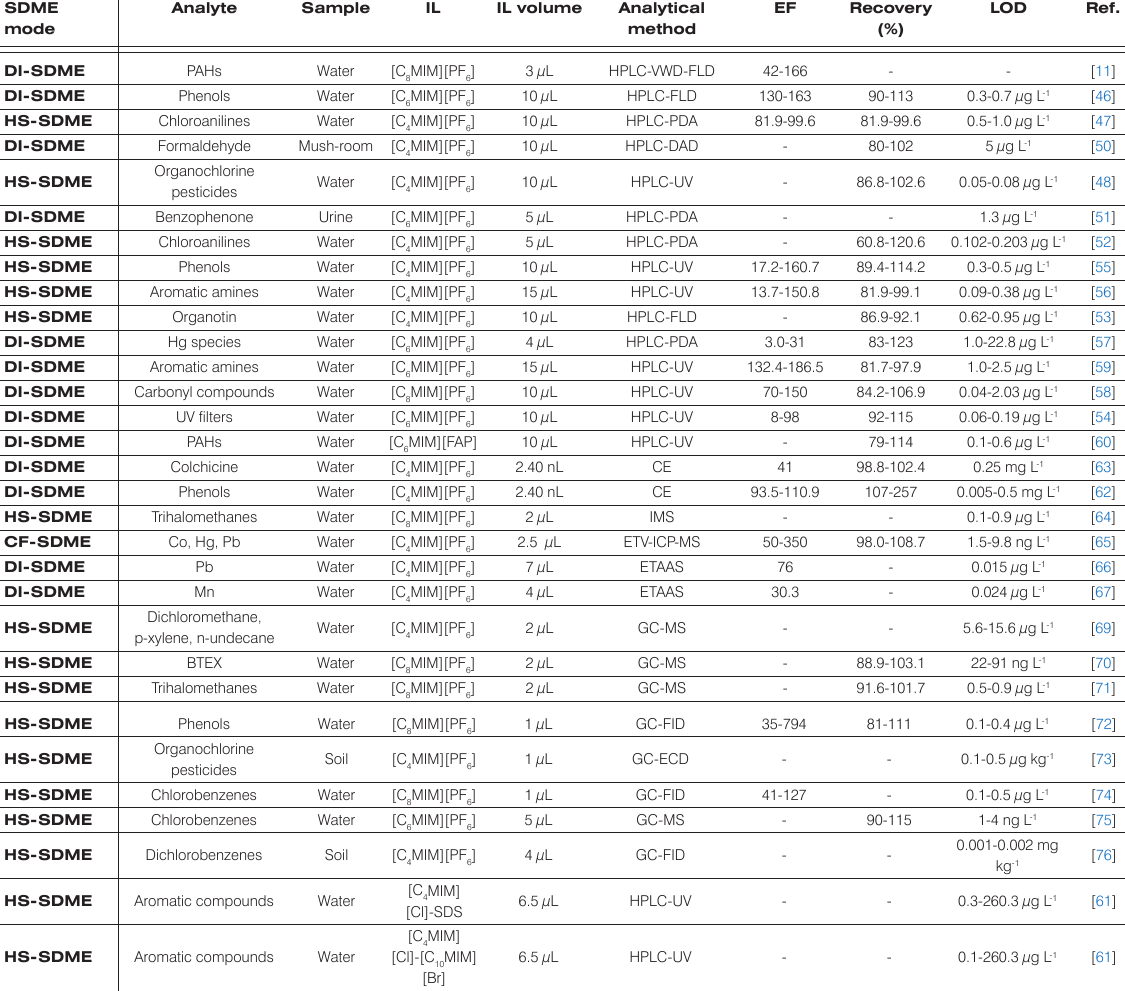
Table 3. R epresentative examples on the use of ILs in